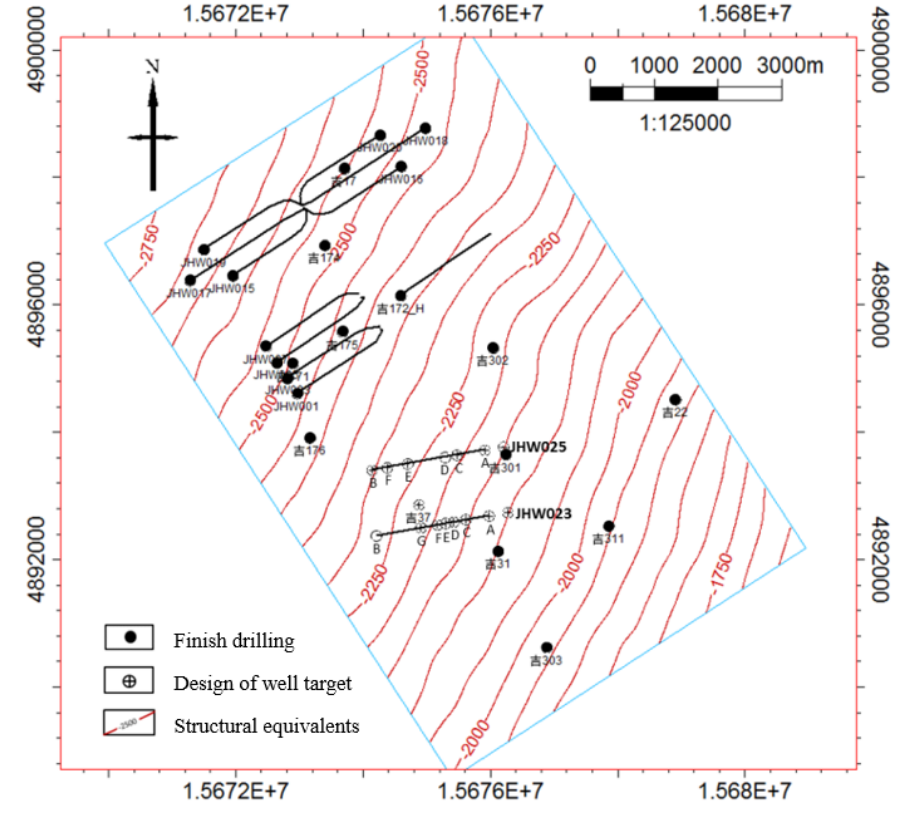
Figure 14. The scheme of the well placement in the oil field.